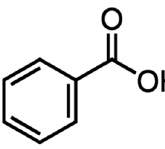
Figure 1. Molecular structure of benzoic acid.